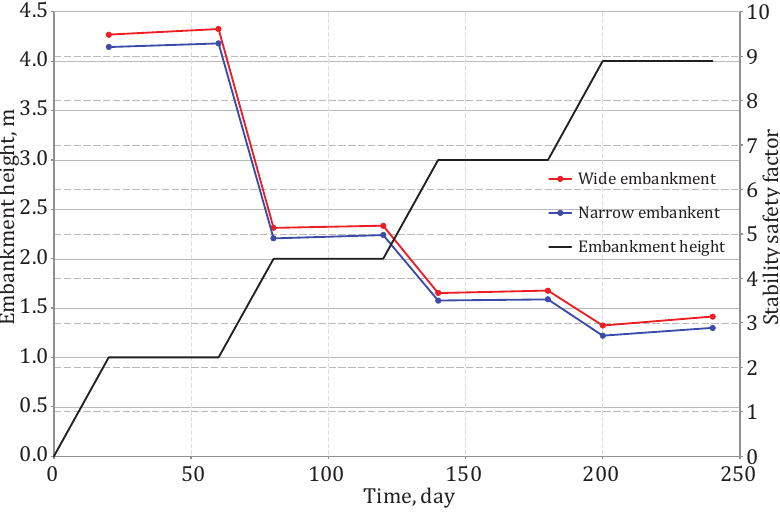
Figure 4. Stability safety